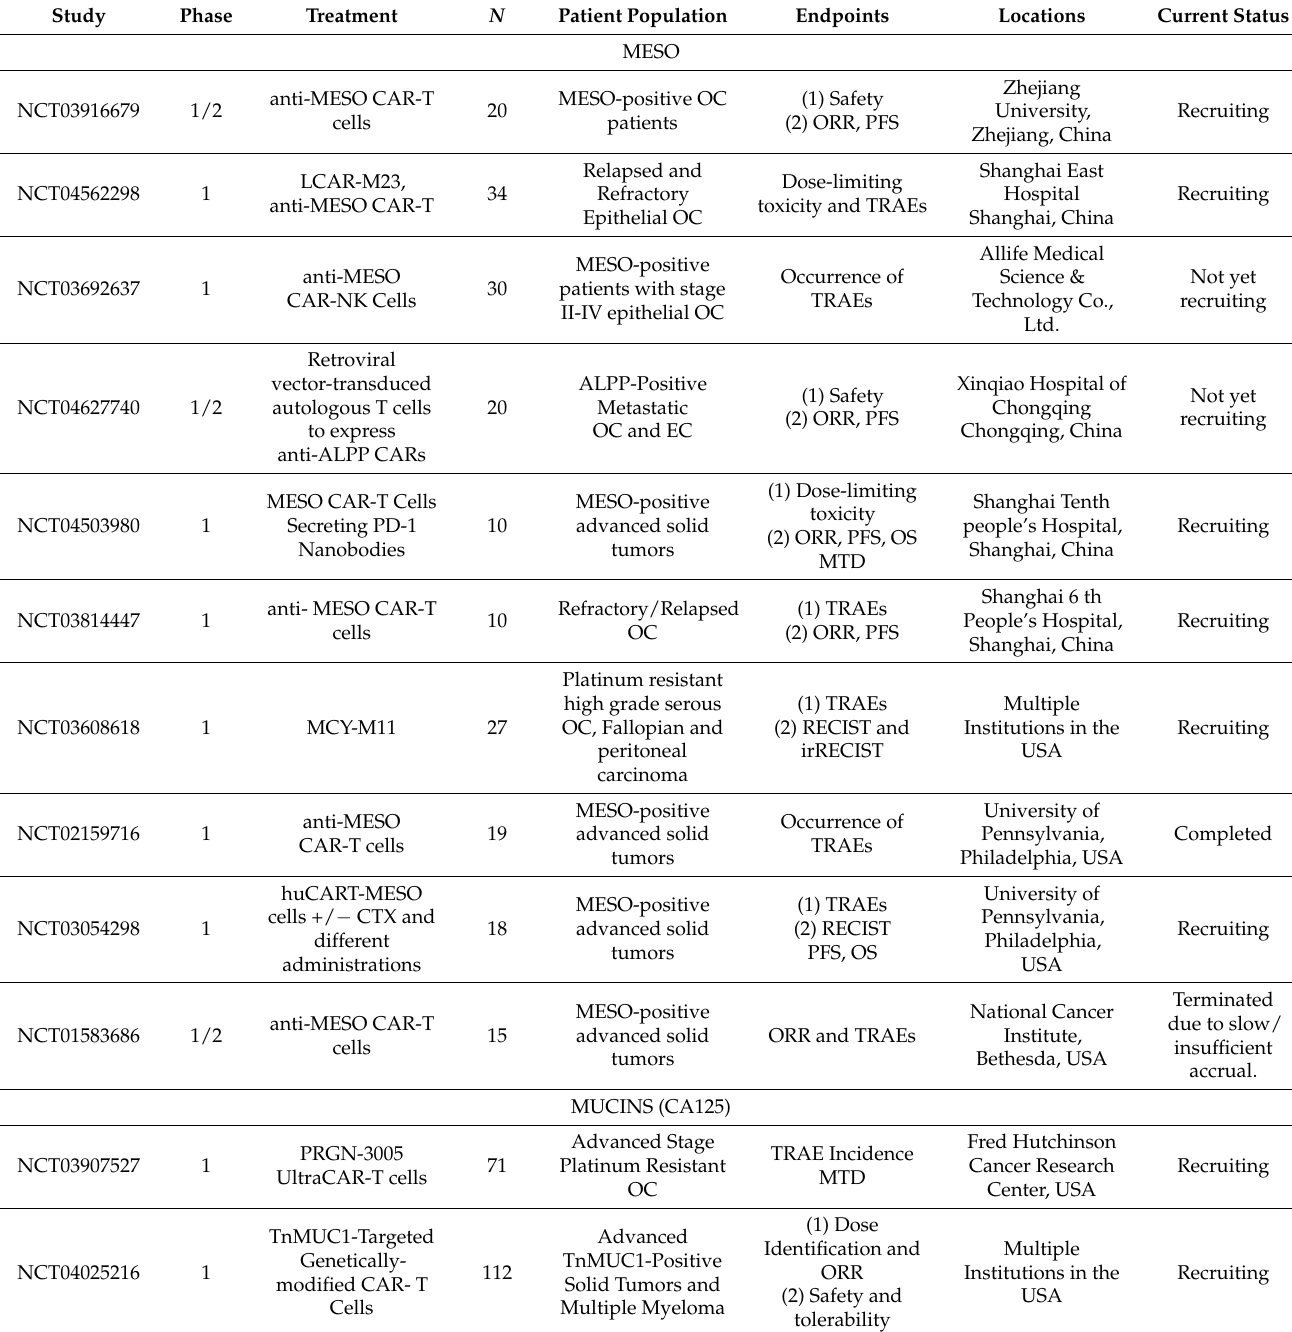
Table 3. Ongoing clinical trials testing CAR-T cell Therapy in